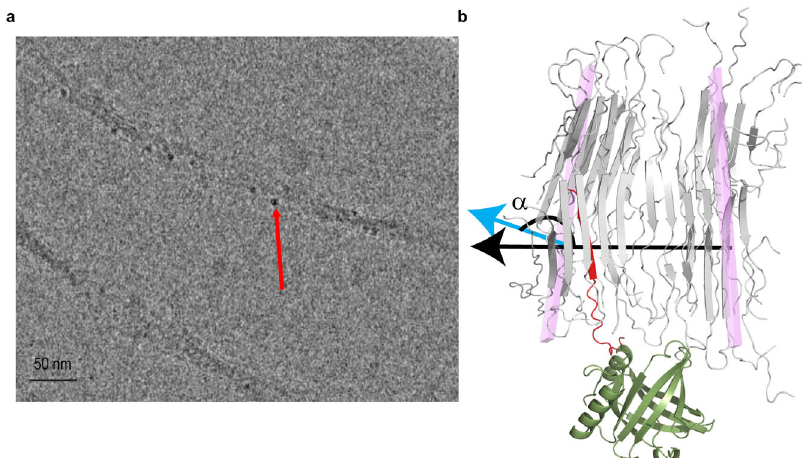
Fig. 2 Binding of L-PGDS to the G623R fi bril. a Representative cryo-EM image of the G623R fi bril and L-PGDS conjugated with heme for contrast enhancement. The red arrow shows the localization of L-PGDS along the convex surface of the fi bril. b Snapshot of MD simulation of the G623R fi bril (light gray) and L-PGDS (olive green) complex at time step 6 ns before the opening of the salt bridge (E615 and R623). The blue and black arrows represent the normal of the plane of 2nd and 9th monomer de fi ned by CA of A620, N622 and H626, respectively. The angle α is formed between the normal of the 2 nd and 9 th planes. The interacting monomer is highlighted in